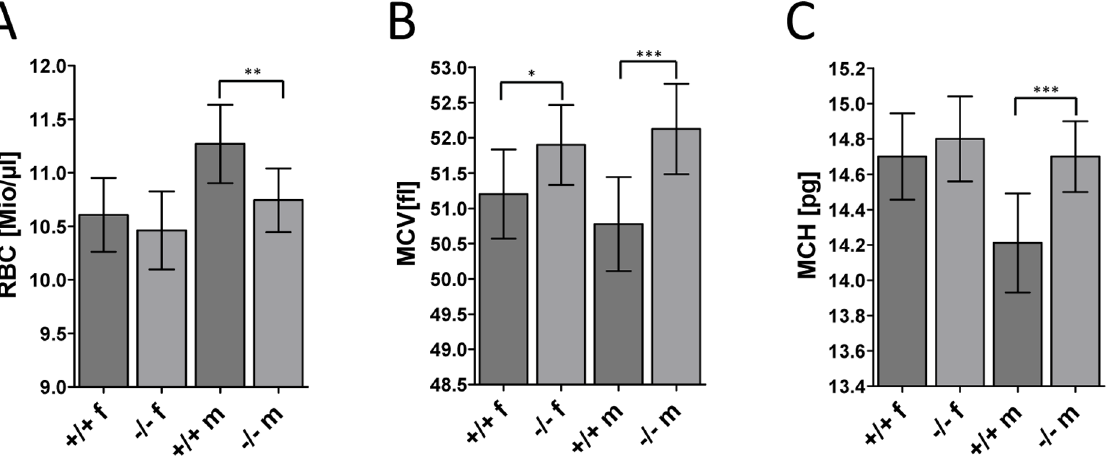
Figure 2. Red blood cells related phenotype in NM1 knock-out mice. ( A ) Comparison of red blood cell counts (RBC) between NM1 KO ( 2 / 2 ) and WT ( + / + ) male (m) and female (f) mice. Male mice show slightly lower number of red blood cells. ( B ) Comparison of mean corpuscular volume (MCV) in WT and KO animals shows increased cell volume in KO males and females. ( C ) NM1 KO animals have increased mean corpuscular hemoglobin (MCH) level in comparison to WT males. Data are presented as mean + / 2 SD. * p , 0.1; ** p , 0.05, *** p , 0.01, **** p , 0.001.